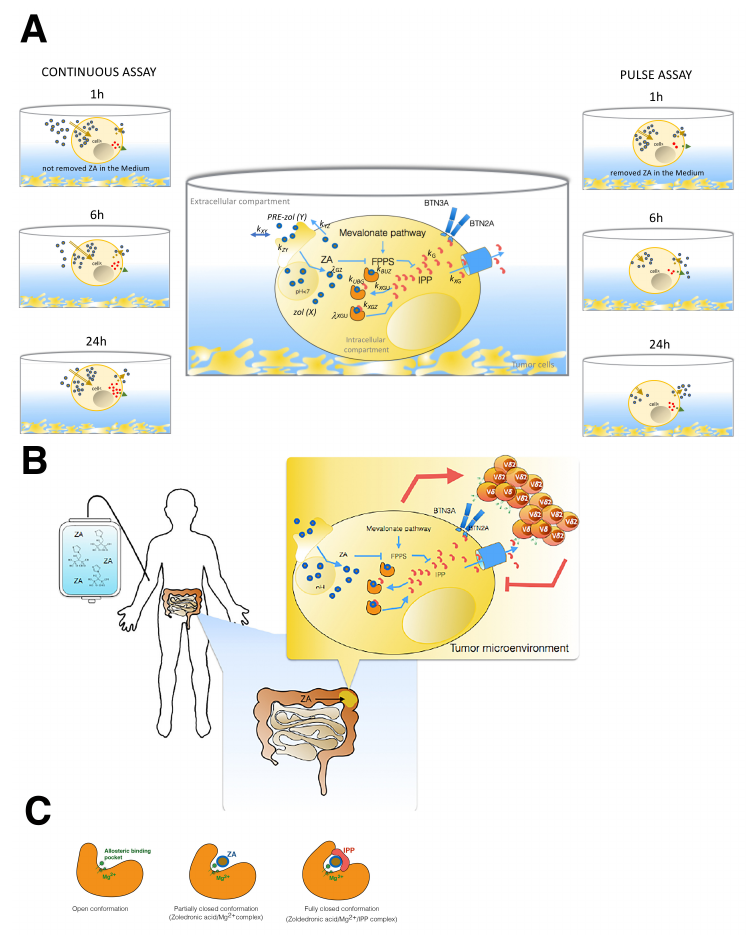
Figure 6. ( A ) Snapshot of the two different assays used by Raikkonen and Benzaid, from which we have extracted data to formulate our mathematical models. On the left is shown the continuous assay in which tumor cells underwent treatment for the whole time of the experiment. On the right is shown the pulse experiment performed by both authors with two different tumor target cells (MCF7, T27D); in this case, the drug was removed after 1 h via medium replacement. In the central part of the figure, we represented zoledronic acid (ZA) pharmacodynamics and IPP into the tumor cells. All process steps are characterized by the calculated parameters in Models 1 and 2. ZA inhibits FPP synthase in the mevalonate pathway through a conformational change in the enzyme. A second conformational change, after the binding of the second substrate, forms a tightly bound inhibition complex that provides a further stabilisation of the FPPS and ZA complex, resulting in the IPP accumulation. The extracellular and intracellular compartments were defined through the cellular borderline. The ZA concentration is proportional to the observations by GS-MS in the intracellular compartment. In each well, the surnatant volume was the extracellular compartment. ( B ) Impact of ZA concentration and exposure time of tumor cells on V γ 9 V δ 2 T cell immune response. In this cartoon, a patient is represented during intravenous ZA infusion, and the possible effects on his tumor cells localised in the gut are also represented. We aim to translate the knowledge acquired by our models on in vitro cell experiments onto patients by focusing on the events occurring in tumor cells upon long treatment of ZA. Finally, we show that IPP accumulation acts on the activation and proliferation of γδ T cells, promoting their anti-tumoral function. ( C ) Illustration of the inhibition mechanism of ZA on FPP synthase determined by a conformational change of enzyme. The first conformation shows in the a pocket site the Mg 2 + involved in the ZA binding. After this opened conformation follows a partially closed conformation, in which the catalytic site is occupied by ZA. The last conformation is the most stable thank to the IPP binding that determines the closed and inactive function of the enzyme